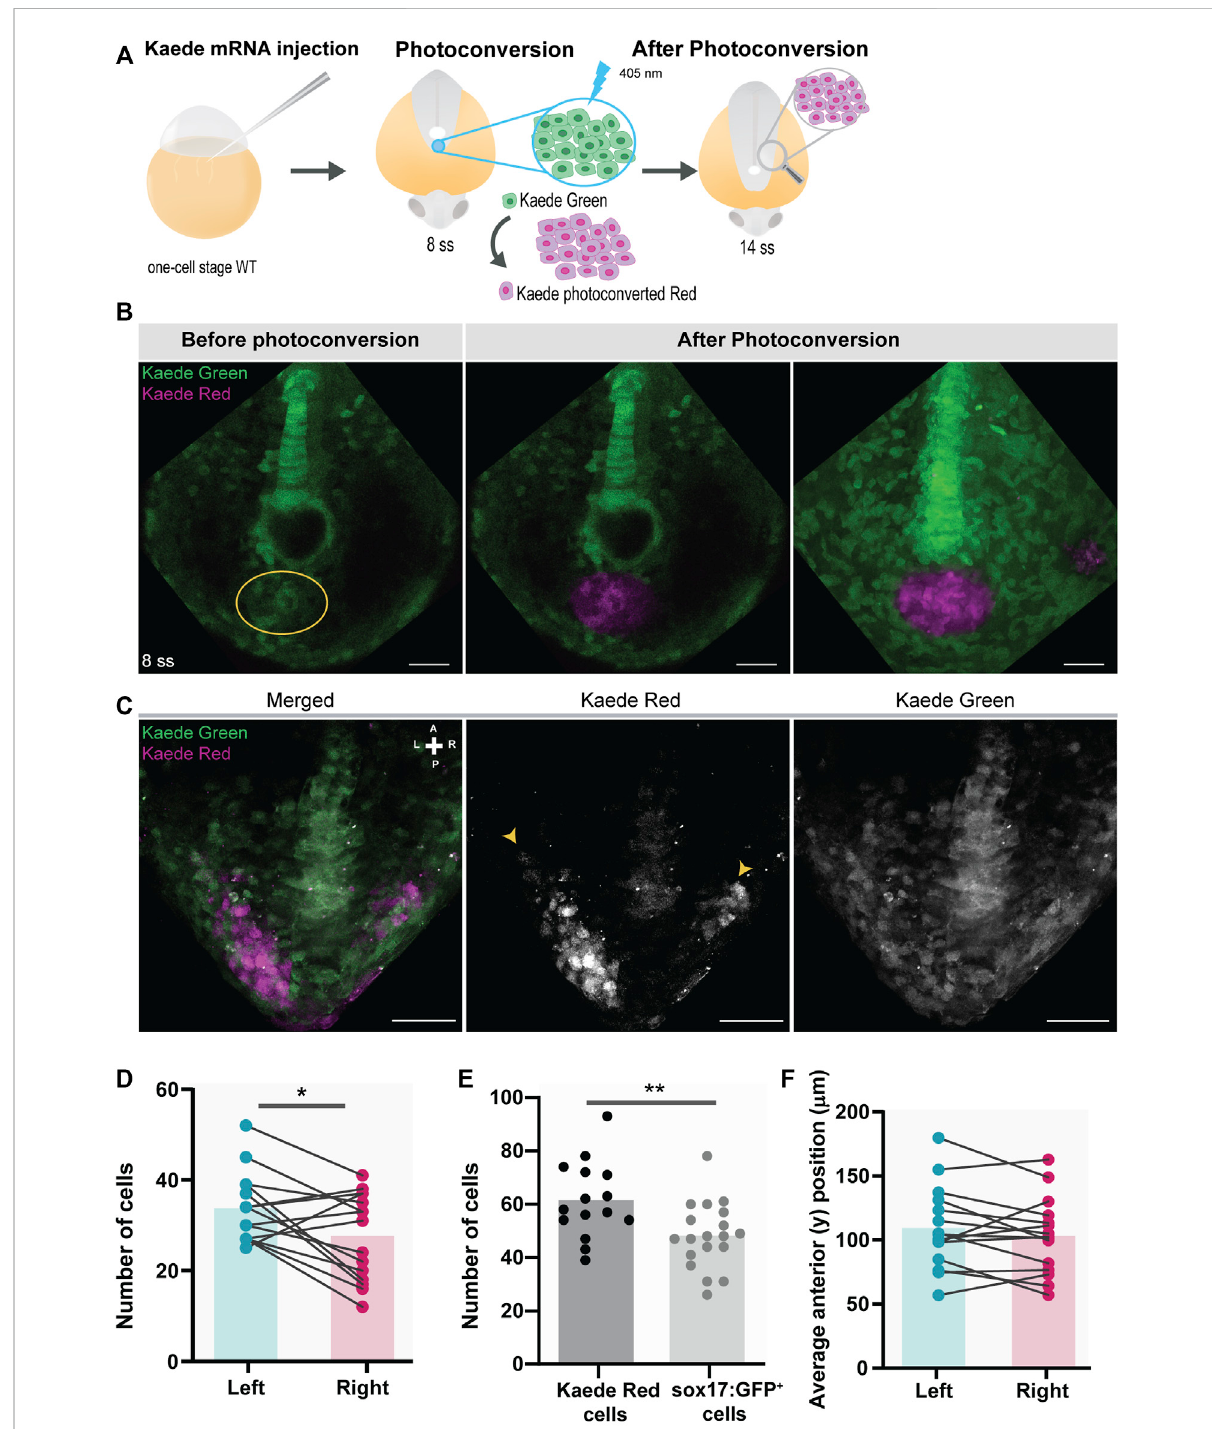
FIGURE 4 Testing for the presence of left-right asymmetries independent of the Tg(sox17:GFP) reporter line. (A) Schematic representation of the setup used to follow speci fi c tailbud cells using the photoconvertible protein, Kaede. One-cell stage WT embryos were injected with Kaede mRNA. The ‘ posterior cluster ’ region was blindly photoconverted at 8 ss embryos using UV light. At 14 ss, embryos were screened for the location of Kaede photoconverted cells. (B) Before and after Kaede photoconversion of the ‘ posterior cluster ’ region at 8 ss in WT embryos. The KV middle focal plane was used as a reference (note that photoconversion can happen along the axial cone of illumination of the confocal, though). The maximum